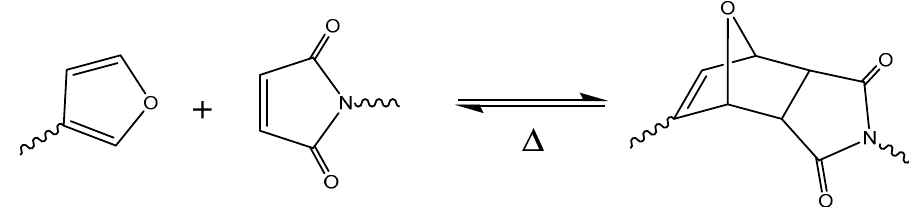
Scheme 12. Representation of the reversibility of furan-maleimide adducts by Diels-Alder process.